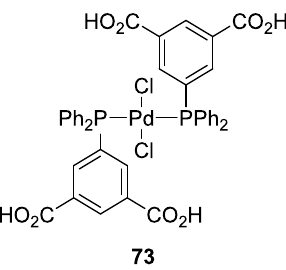
Figure 22. Palladium(II) complex 73 employed as linker in the preparation of a